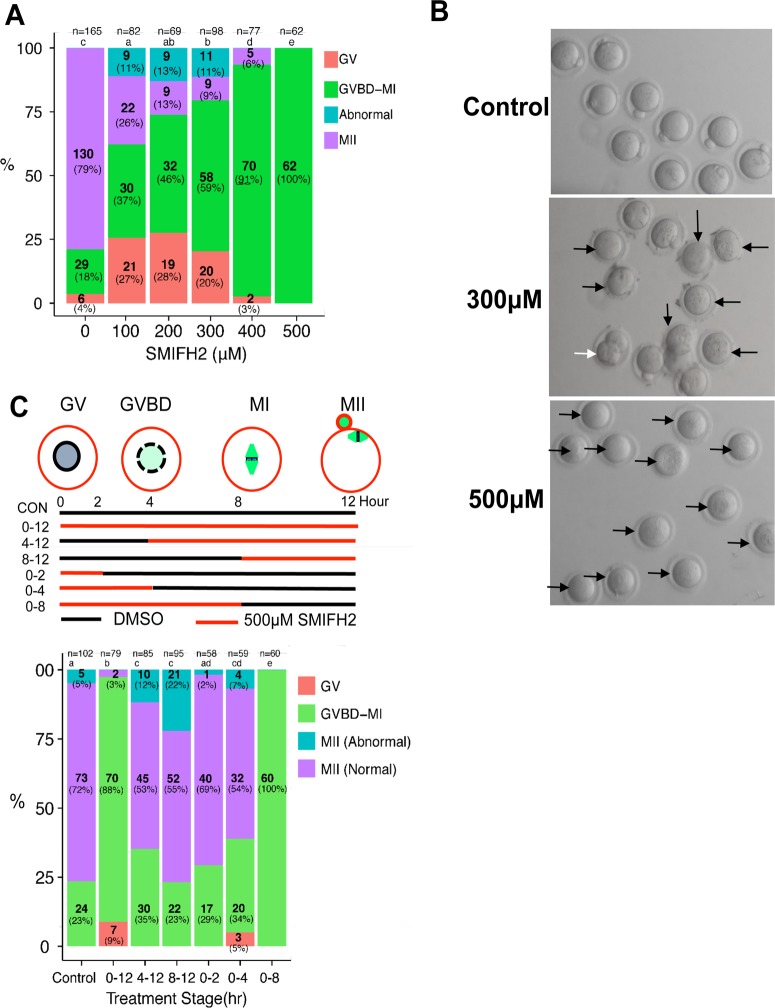
The formin inhibitor SMIFH2 blocks mouse oocyte maturation.
A. Treatment with SMIFH2 decreases the oocyte maturation rate and increases the ratio of symmetric division. SMIFH2 was added to M16 culture medium at concentrations of 0, 100, 200, 300, 400, and 500 μM and immature oocytes were cultured for 12 h after which their status of development was assessed. At least 3 independent experiments were carried out and the ratios of oocytes at each developmental stage to total oocytes were plotted. Significant differences (p < 0.05) between the treated groups are indicated by a different superscript letters(a,b,c,d and e). B. Representative pictures of oocytes treated with SMIFH2. White arrows indicate abnormally matured oocytes, while black arrows mark oocytes that failed to mature at the MII stage after 12 h of growth. C: Treatment with SMIFH2 for distinct durations and the effect thereof on oocyte maturation. CON: control group without SMIFH2 treatment; 0–12: the oocytes were treated with 500 μM of SMIFH2 during the entire incubation time; 0–2, 0–4, 0–8: the oocytes were treated with 500 μM of SMIFH2 during 0–2, 0–4, and 0–8 h after the start of incubation, respectively, and then transferred to fresh M16 medium without SMIFH2; 4–12, 8–12: the oocytes were cultured without SMIFH2 for 4 and 8 h, respectively, after which 500 μM of SMIFH2 was added to the medium. Maturation ratios after 12 h of incubation for each treatment group are plotted. Statistical differences (p < 0.05) between different treatments are indicated by a different superscript letters(a,b,c,d and e).